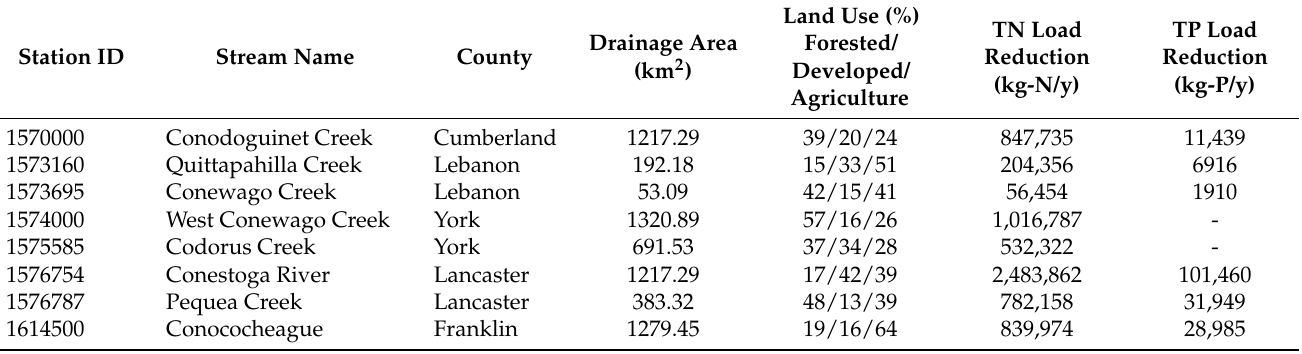
Table 1. Information regarding drainage area, percentage of land use (agricultural, forested, and urban), and annual load-reduction goals for total nitrogen (TN) and total phosphorus (TP) for each selected study site in the Pennsylvania portion of the Chesapeake Bay watershed. Land use is based on USGS 2016 National Land Cover Data